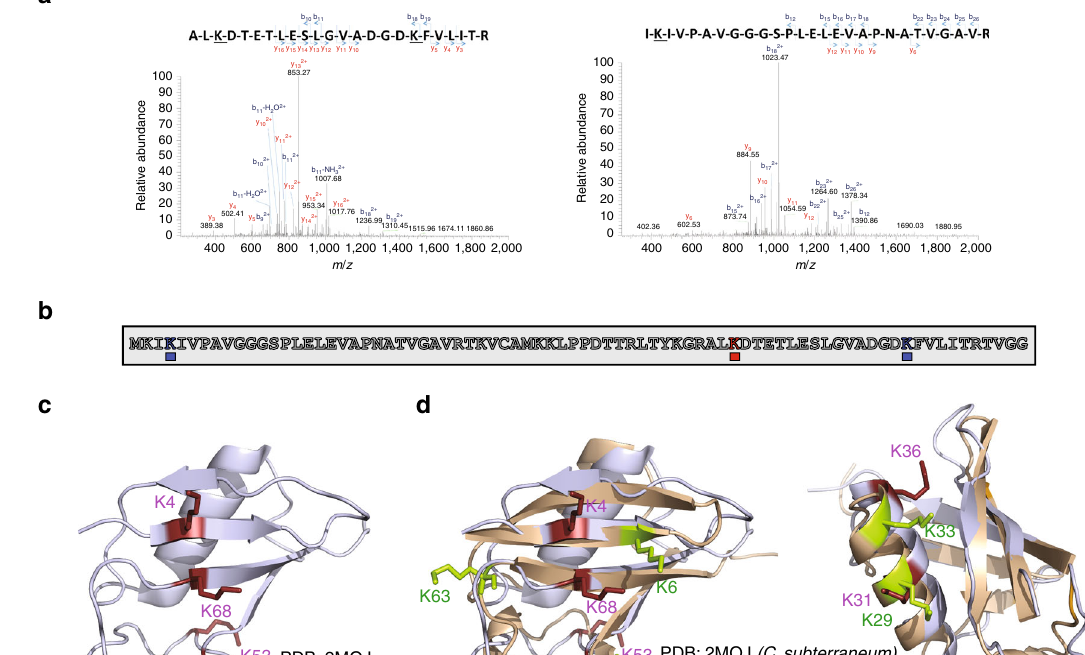
PDB: 2MQJ (C. subterraneum)